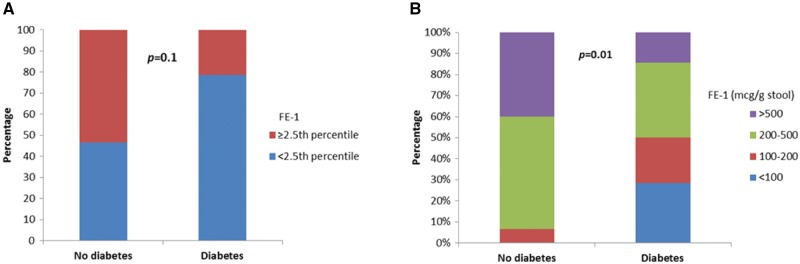
Bar charts showing the percentage of individuals with HNF1B-associated disease according to diabetes status with faecal elastase-1 (FE-1) measurements (A) either below or above the 2.5 percentile of a healthy control cohort and (B) <100 μg/g stool (suggestive of severe pancreatic exocrine insufficiency), 100–200 μg/g stool (moderate to mild insufficiency), 200–500 μg/g stool and >500 μg/g stool.